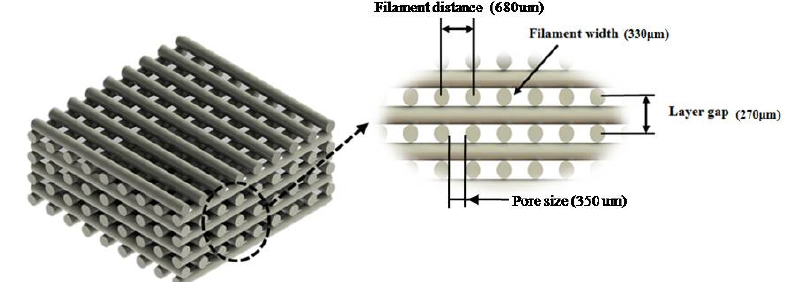
Figure 12 . 0/90° lay ‐ down pattern and design characteristics.